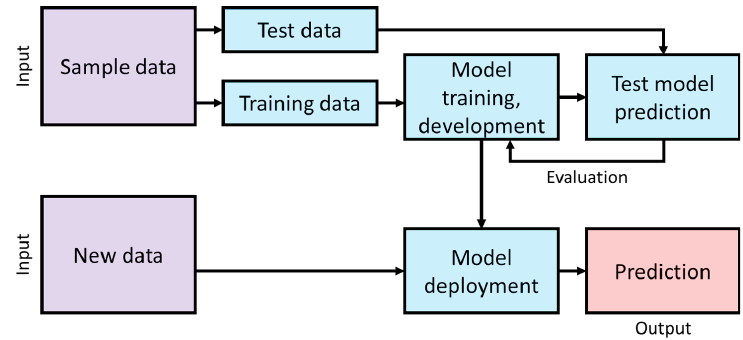
Figure 7. Machine learning model